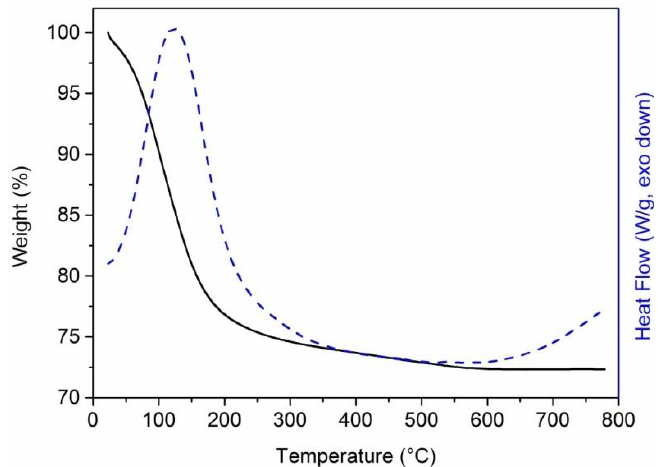
Figure 1. Thermal gravimetric analysis (TGA) (continuous line) and differential scanning calorimetry (DSC) (dashed line) curves of the neat geopolymer cured at room temperature for seven days in 99% relative humidity conditions.